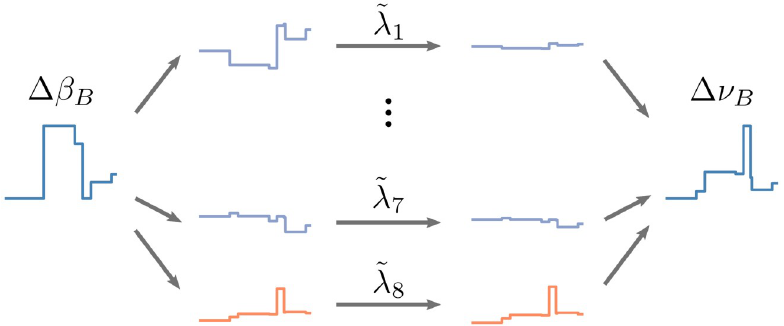
Fig 8. Eigenmode decomposition of input and output. Left: The baseline component of the input perturbation Δ β decomposed into the eight input modes ξ its individual gain factor ~ l output perturbation Δ ν B